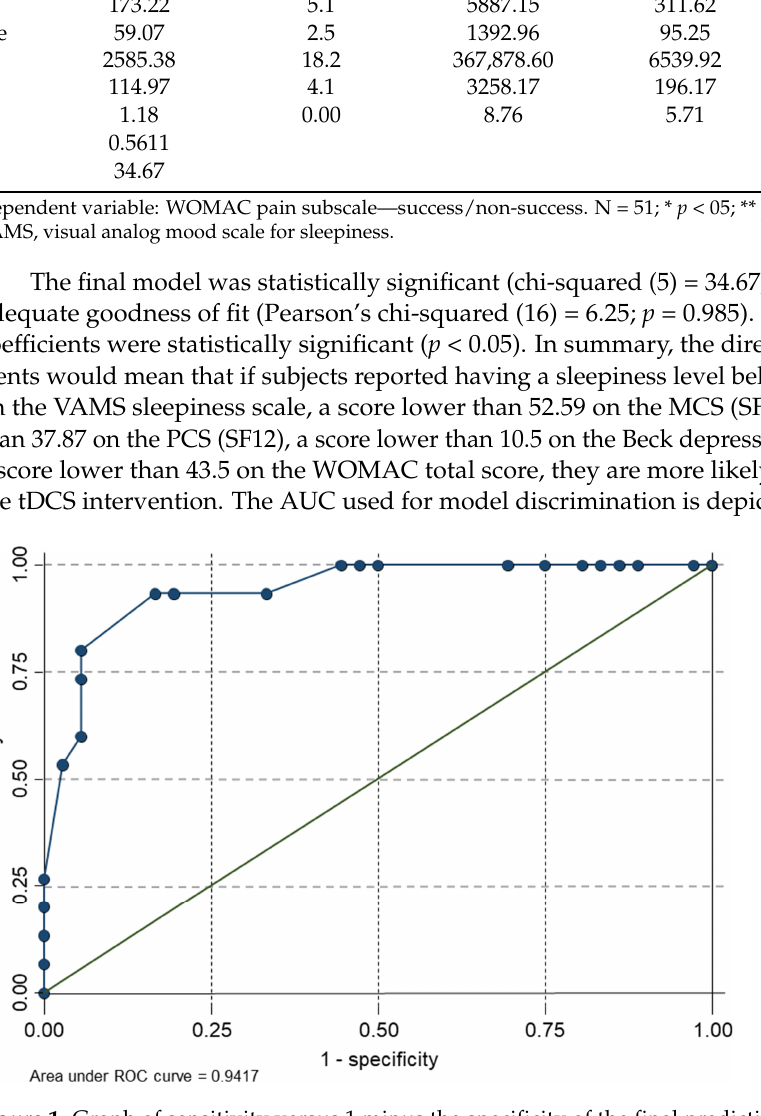
Table 2. Final predictive multivariate logistic model.